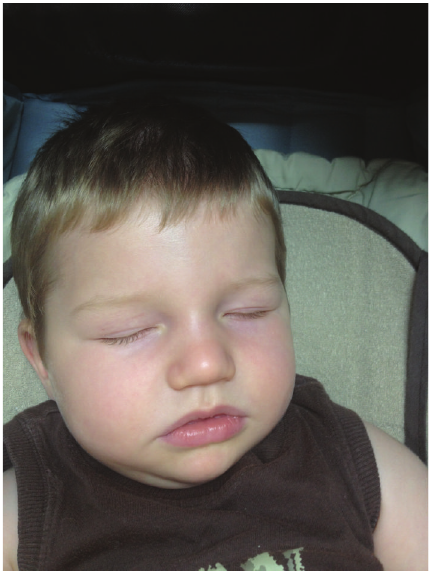
Figure 1: Facial appearance. Dysmorphic features, broad nasal root, and thin upper lip.